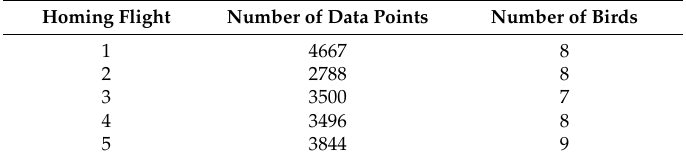
Table 1. Number of data points and number of birds in each empirical homing